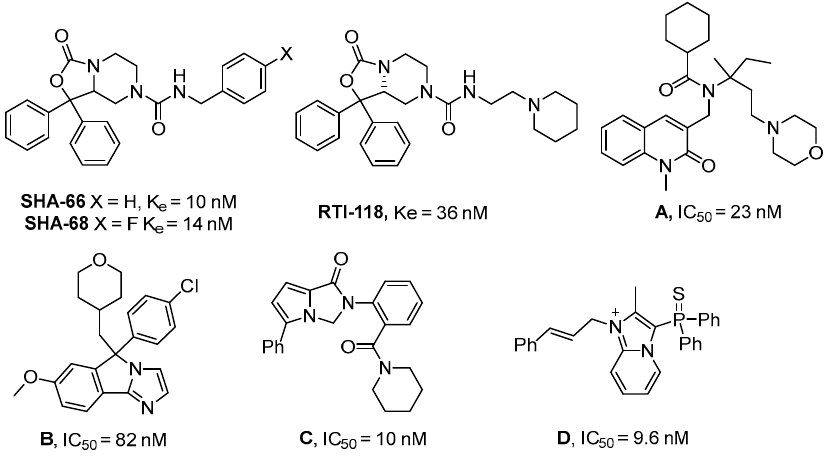
Figure 1. Representative NPSR antagonists.